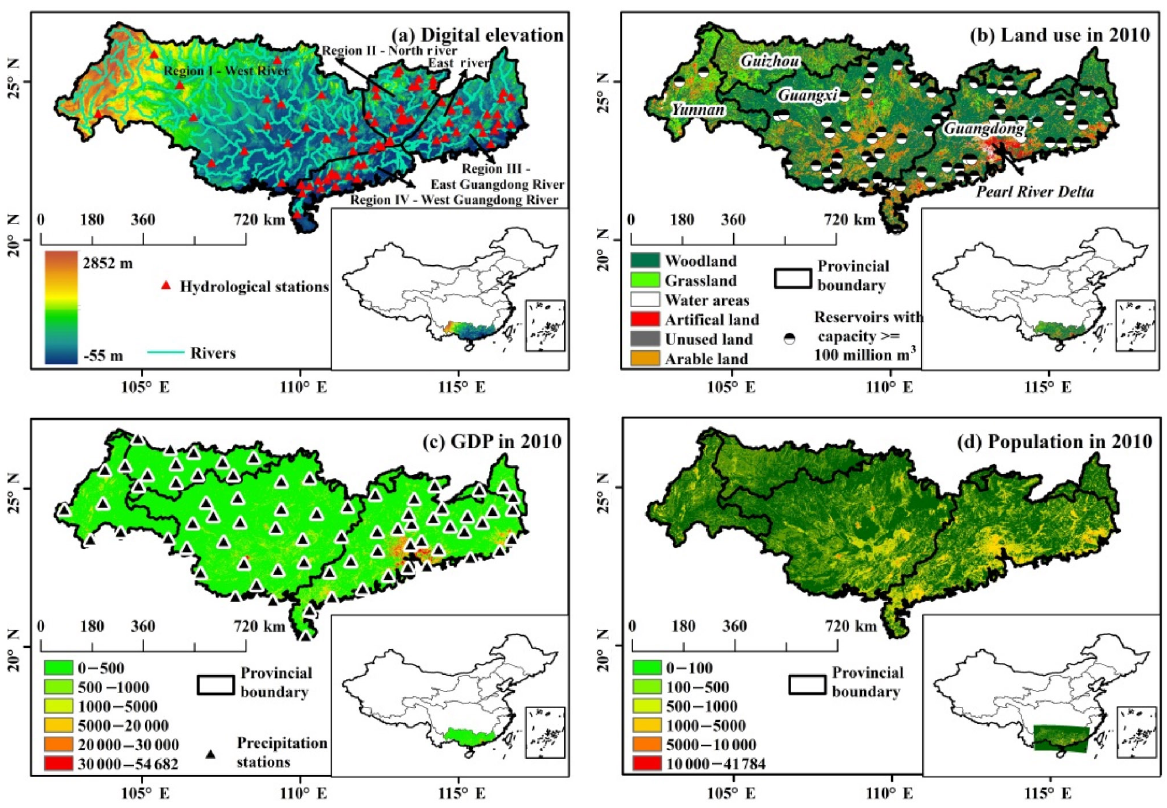
Figure 1. Locations of hydrological stations, precipitation gauging stations, and water reservoirs, and spatial patterns of land use, socio- economy, and population across the Pearl River